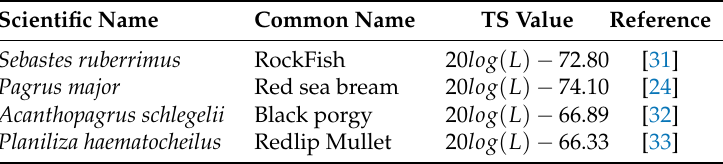
Table 5. TS at 200 kHz of some common fish farmed in